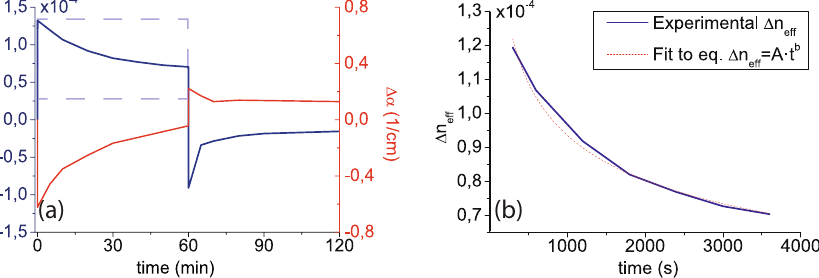
Figure 2. Experimental effective index change and absorption time evolution. ( a ) Time evolution of the absorption and effective index change for the soaking experiments. At the high voltage phase, shown in a dashed square, voltage was kept constant at − 120 V during the first 60 minutes. The recovery phase at 0 V was monitored during the subsequent hour. ( b ) Effective index fit to the theoretical time dependency of Eq. (1) for the high voltage